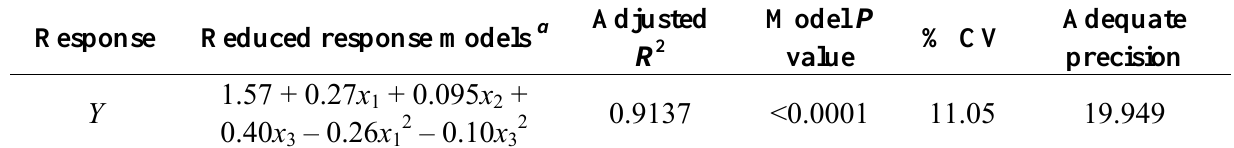
Table 3. Reduced response models and statistical parameters obtained from ANOVA (after backward elimination).